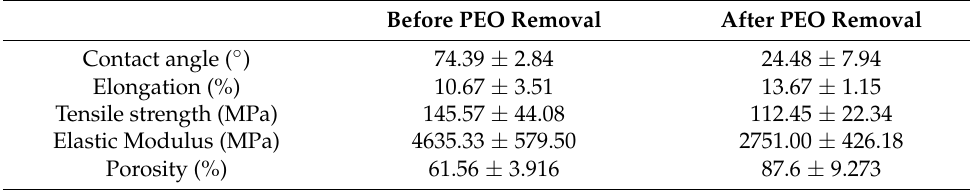
Table 3. Characterization of FP 6-4.